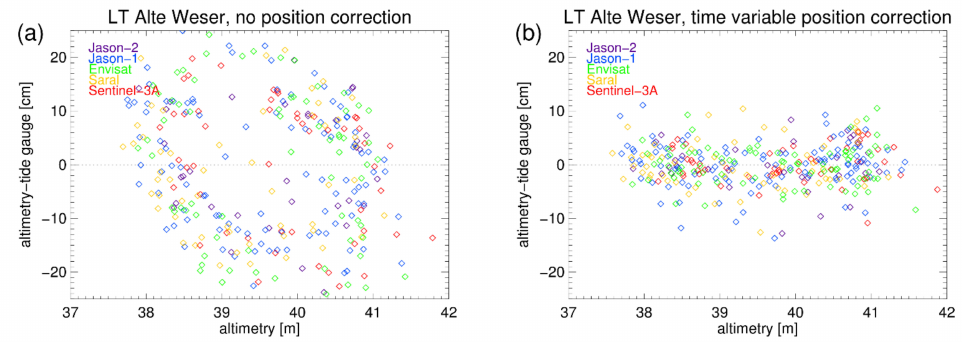
Figure 5. Difference between altimetry and tide gauge as function of absolute height for the five missions available at station LT Alte Weser ( a ) without and ( b ) with time variable position correction ( ∆ t: 14–19 min., scaling factor: